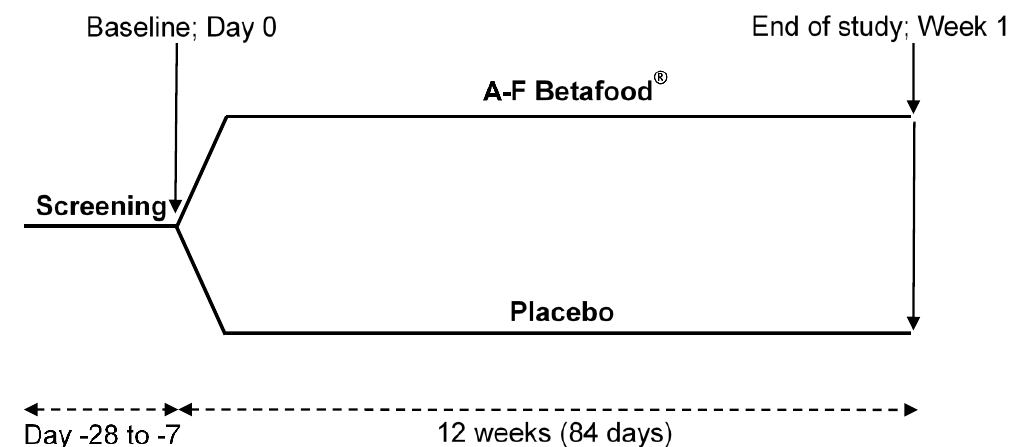
Figure 1. Schematic representation of clinical trial design. Fifty participants were enrolled in a 12-week double-blind, randomized, placebo-controlled, two-arm parallel study. All participants enrolled in the study completed all study related assessments at baseline (Day 0) and 12 weeks post- supplementation.